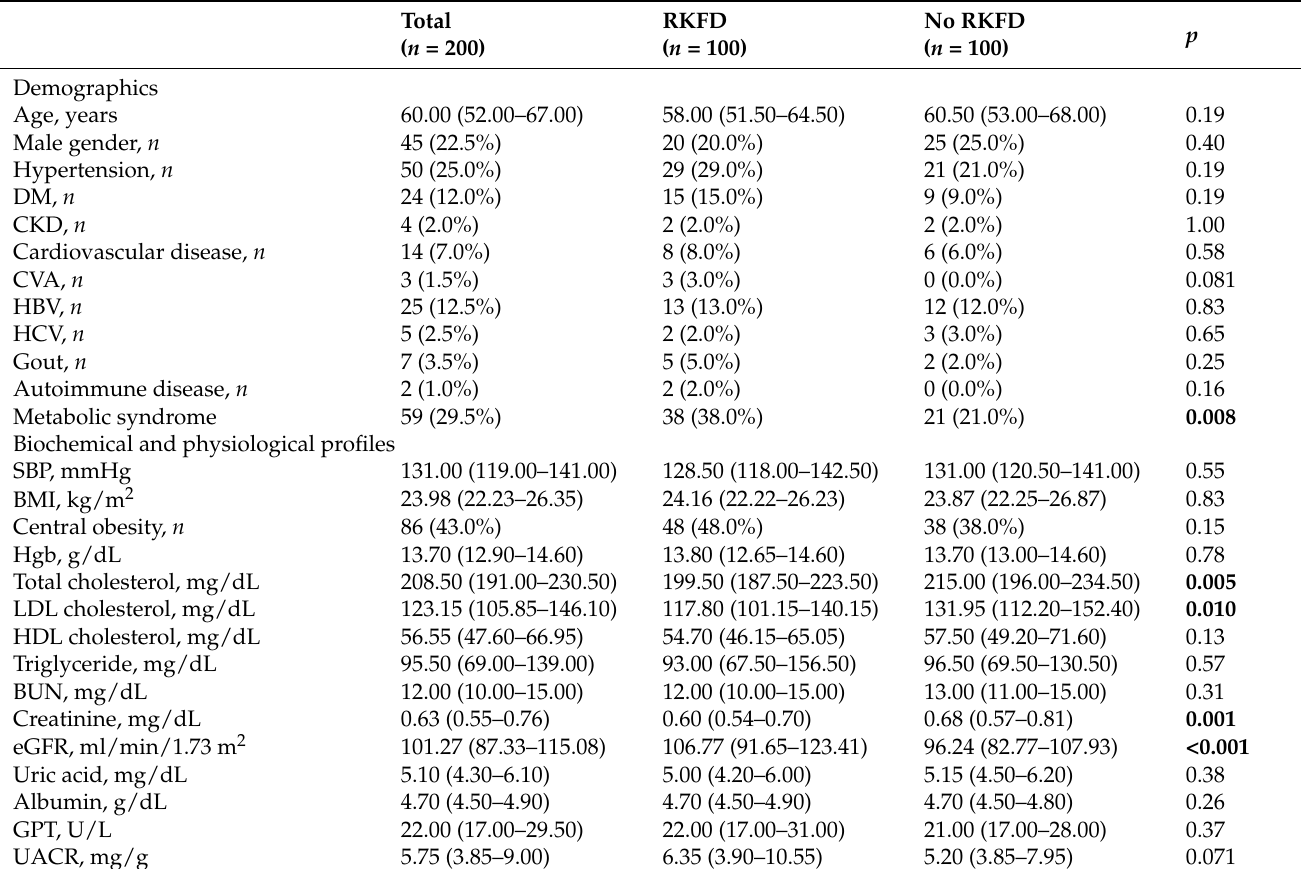
Figure 1. Flow diagram of this study. Abbreviations: NTCMRC, Northeastern Taiwan Community Medicine Research Cohort; RKFD, rapid kidney function decline. Table 1. Baseline characteristics of the study population.